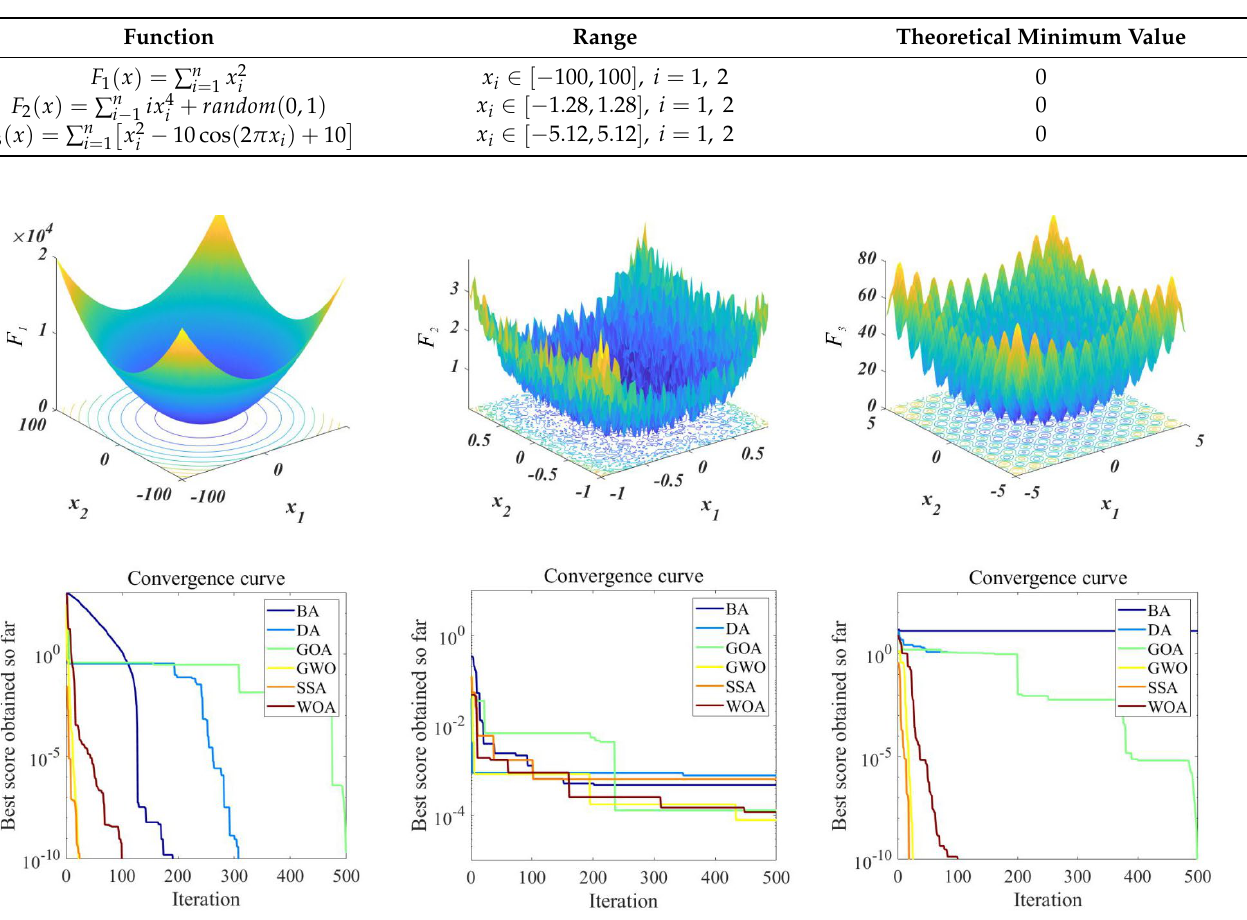
Table 4. Parameter and results of each optimization algorithm. Algorithm